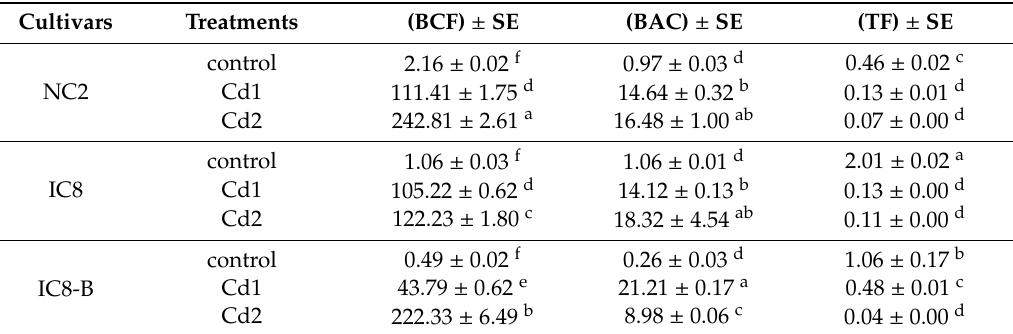
Table 6. Bioconcentration factor (BCF), bioaccumulation coe ffi cient (BAC) and translocation factor (TF) of chickpea seedlings grown in a nutrient medium under Cd stress at the rate of 0 µ M (control), 25 µ M (Cd1) and 50 µ M (Cd2) with mean values ± SE, ( n =